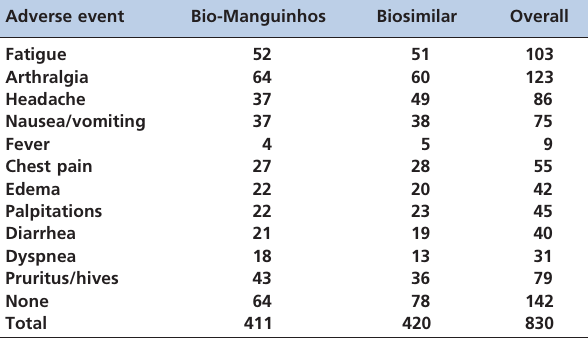
Table 3 - Number of adverse events reported by patients during monthly follow-up